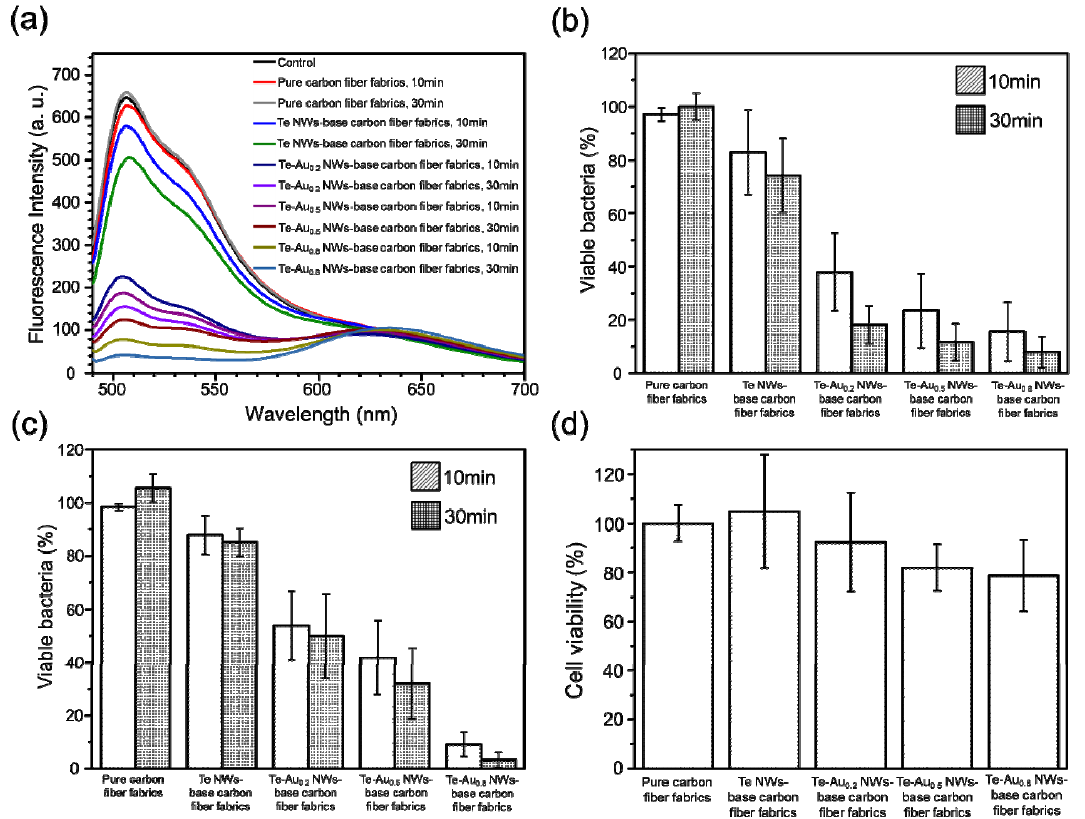
Figure 4. The antibacterial activity and cytotoxicity of carbon fiber fabrics with Te and Te-Au NWs. ( a ) Fluorescence spectra of the E. coli solutions (2.0 × 10 8 bacteria/mL) stained with SYTO 9 and PI. The as-prepared carbon fiber fabrics were immersed in the E. coli solutions for 10 and 30 min. The emission ratio of 530 nm/640 nm was used as an indicator to evaluate the antibacterial activity. Viable ( b ) E. coli and ( c ) S. aureus cells were calculated by the emission ratio of 530 nm/640 nm. ( d ) Cell viability of MCF-10A cells incubated with the Te and Te-Au NW-based carbon fiber fabrics for 24 h.